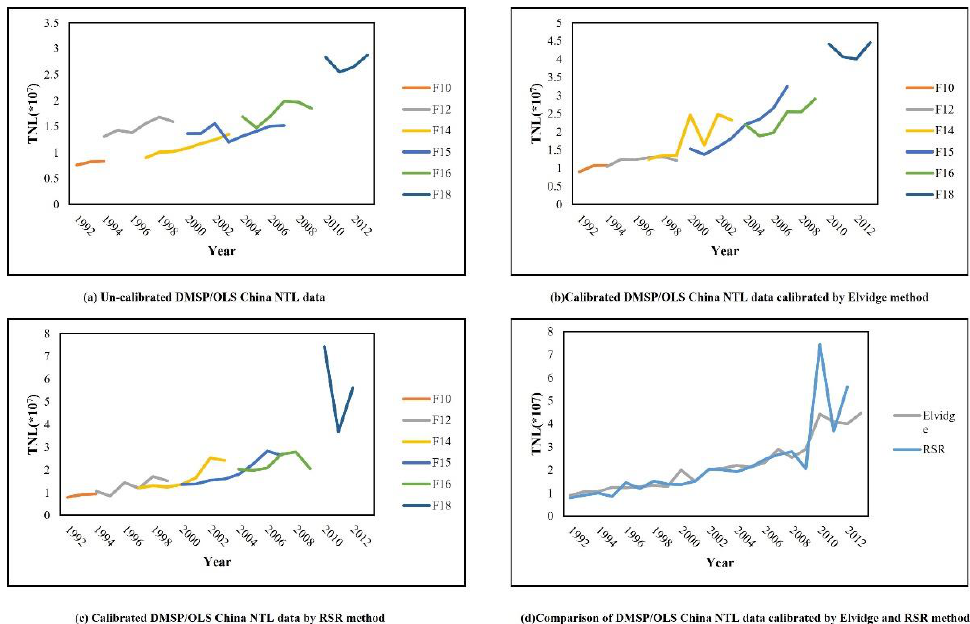
Figure 3. The DMSP/OLS NTL data before and after the calibrations using two different methods. (( a ) Un-calibrated DMSP/OLS NTL data, ( b ) Calibrated NTL data calibrated by Elvidge method, ( c ) Calibrated NTL data by RSR method, ( d ) Comparison of DMSP/OLS NTL data calibrated by Elvidge and RSR method). According to the standard errors calculated by overlapping satellites, the calibration errors of the NTL images of different satellites in the same year based on different calibra- tion methods are shown in Table 3. The 𝑆𝑁𝐸 𝑟𝑎𝑤 of the uncalibrated DMSP/OLS data was 2.033. In comparison, the 𝑆𝑁𝐸 𝐸𝑙𝑣𝑖𝑑𝑔𝑒 was 1.132, while the calculated 𝑆𝑁𝐸 𝑅𝑆𝑅 was 1.108.